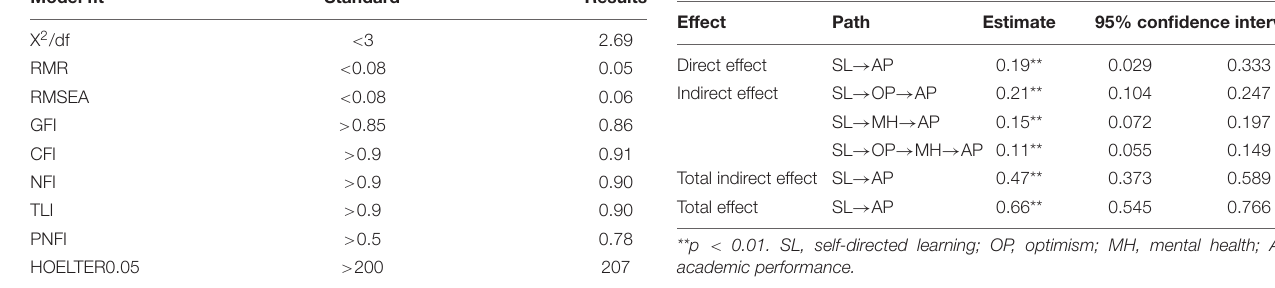
TABLE 6 | Bootstrap path effect